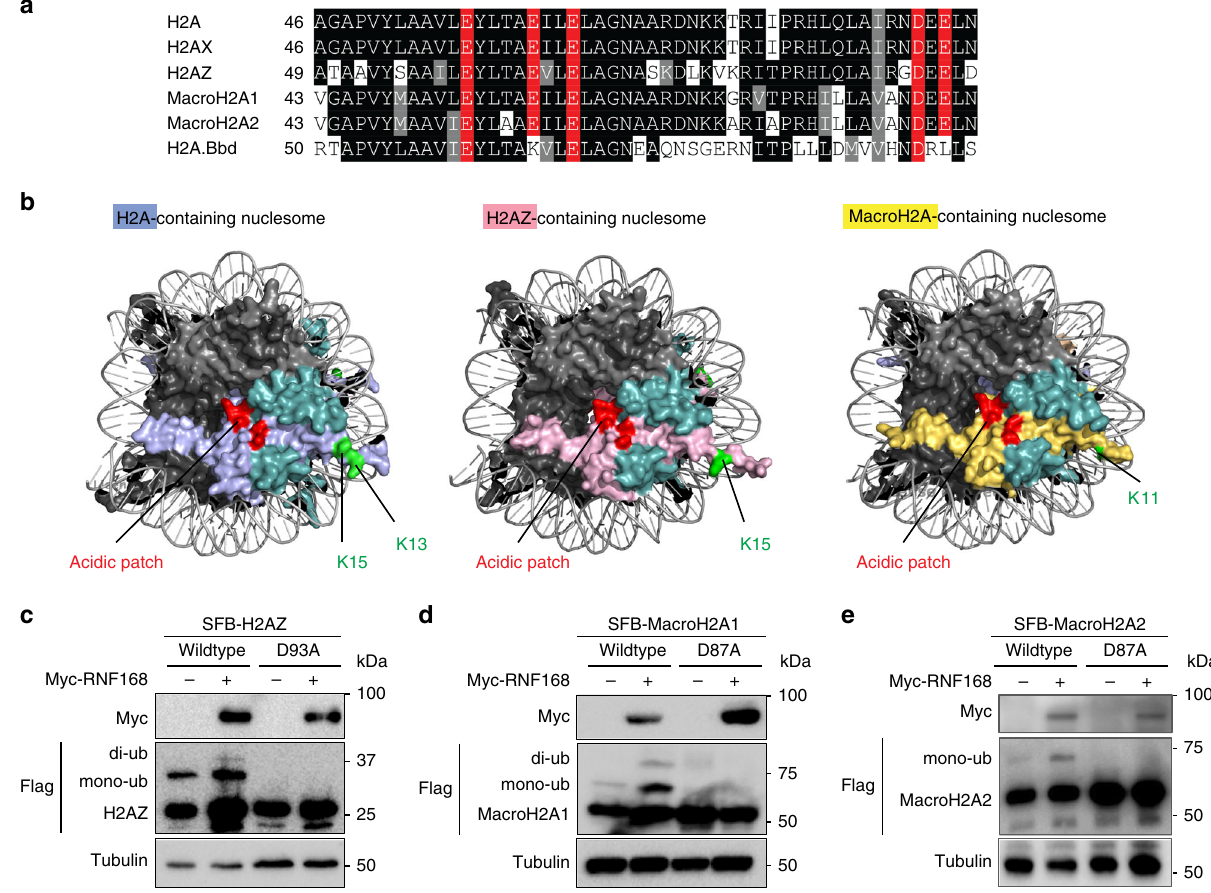
Fig. 3 Mutation of the acidic patches of H2A variants impairs ubiquitination. a H2A variants have an evolutionary conserved acidic patch. The graphic represents sequence alignment of H2A variants. Acidic residues required to form an intact acidic patch were highlighted in red. b Structural illustration of the H2A-containing, H2AZ-containing and MacroH2A-containing nucleosome. H4 is in light gray, H3 is in dark gray, H2B is in teal, and H2A variants are in the following colors: H2A – light blue; H2AZ – pink; MacroH2A – yellow. The evolutionary and structurally conserved acidic patch is in red and the RNF168- targeted lysine residues are in green. c – e The acidic patch of H2A variants is required for RNF168-mediated site-speci fi c ubiquitination. HEK293T cells were transfected with Myc-RNF168 and SFB-H2A variants and their acidic patch mutants (H2AZ-D93A; MacroH2A1-D87A; MacroH2A2-D87A) as indicated. Cells were harvested 24 h after transfection and ubiquitinations were analyzed by western blot with indicated antibodies. Repeated three times independently with similar results. Source data are provided as Source Data fi